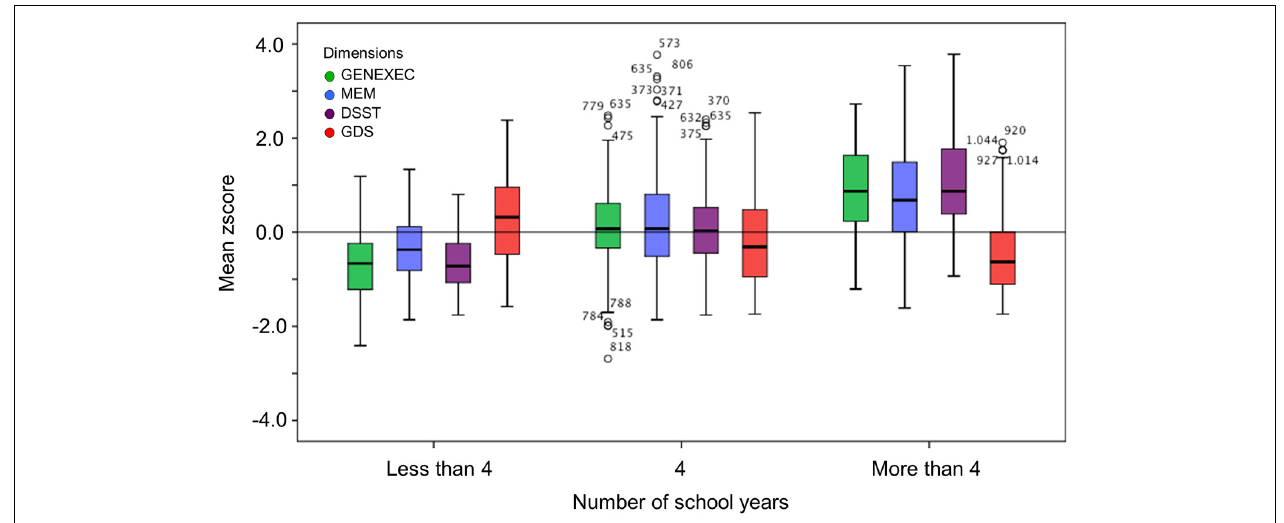
FIGURE 2 | Box-and-Whisker plots for cognitive and mood performance in the “more than 4,” “4,” and “less than 4” school years school groups. First quartile, median, third quartile, interquartile range, outliers, and boundaries for outliers are represented.